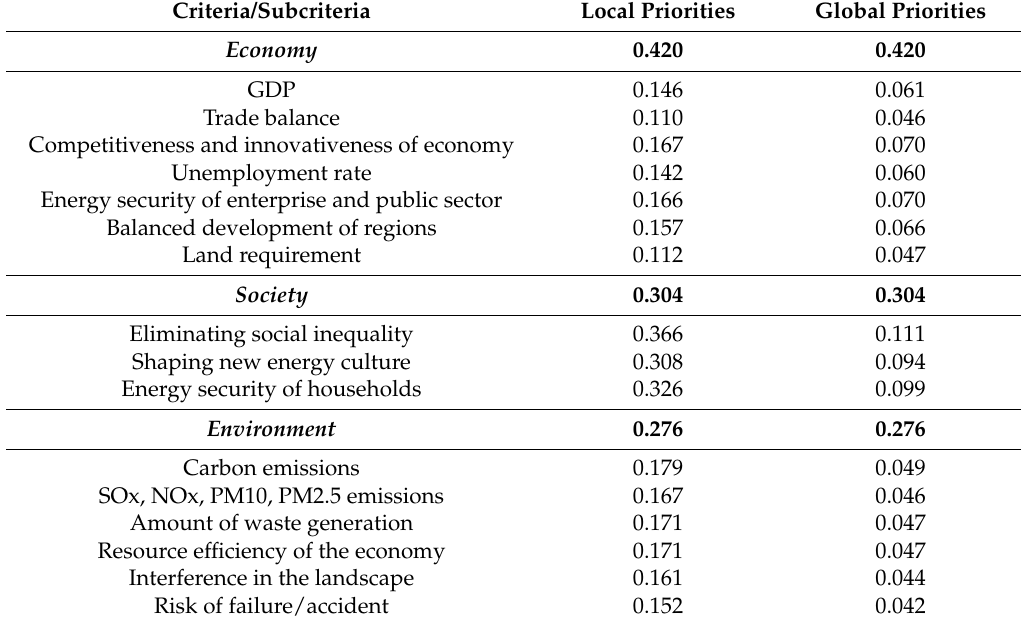
Table 6. Local and global priorities for criteria and